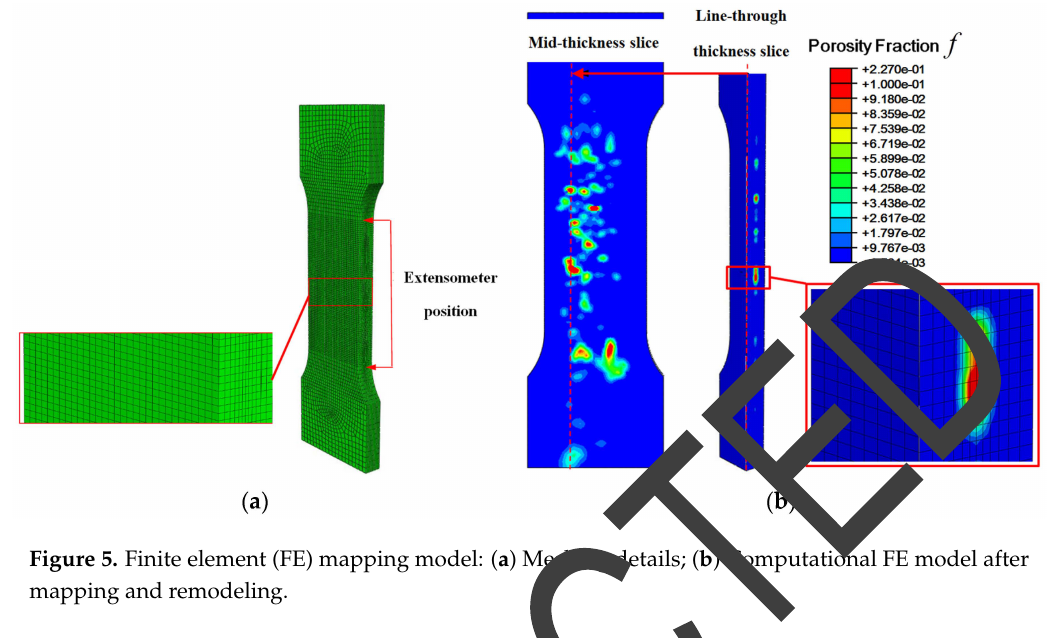
Figure 5. Finite element (FE) mapping model: ( a ) Meshing details; ( b ) Computational FE model after mapping and remodeling.